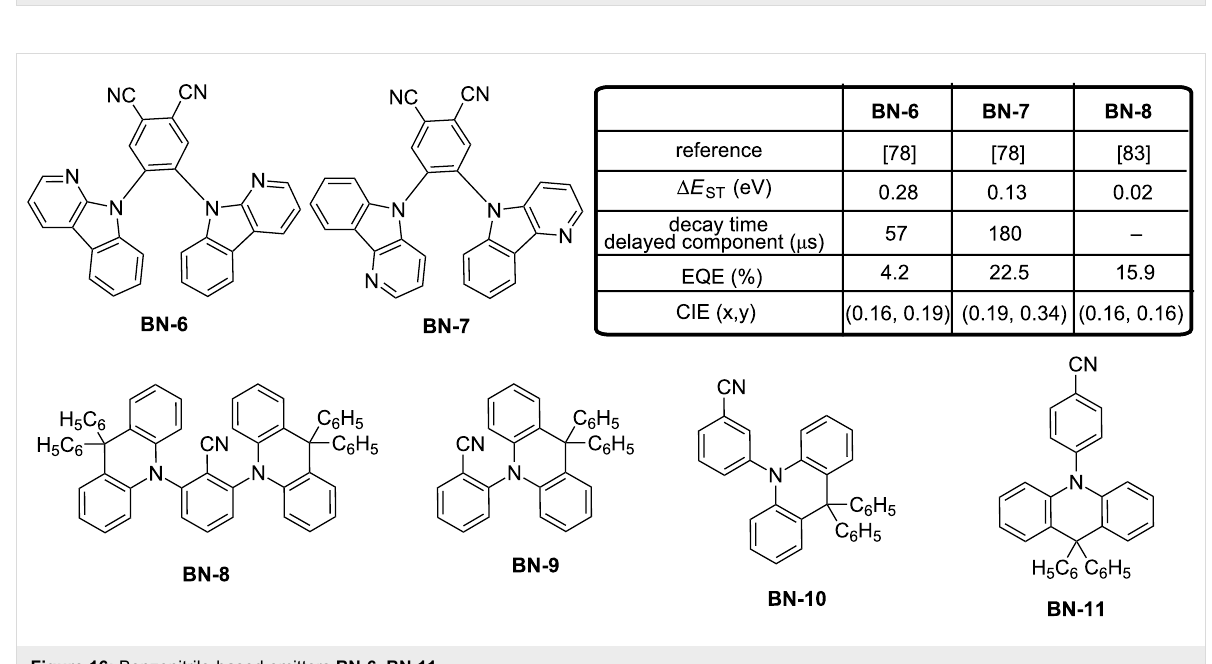
Figure 15: Benzonitrile-based emitters BN-1 – BN-5 .